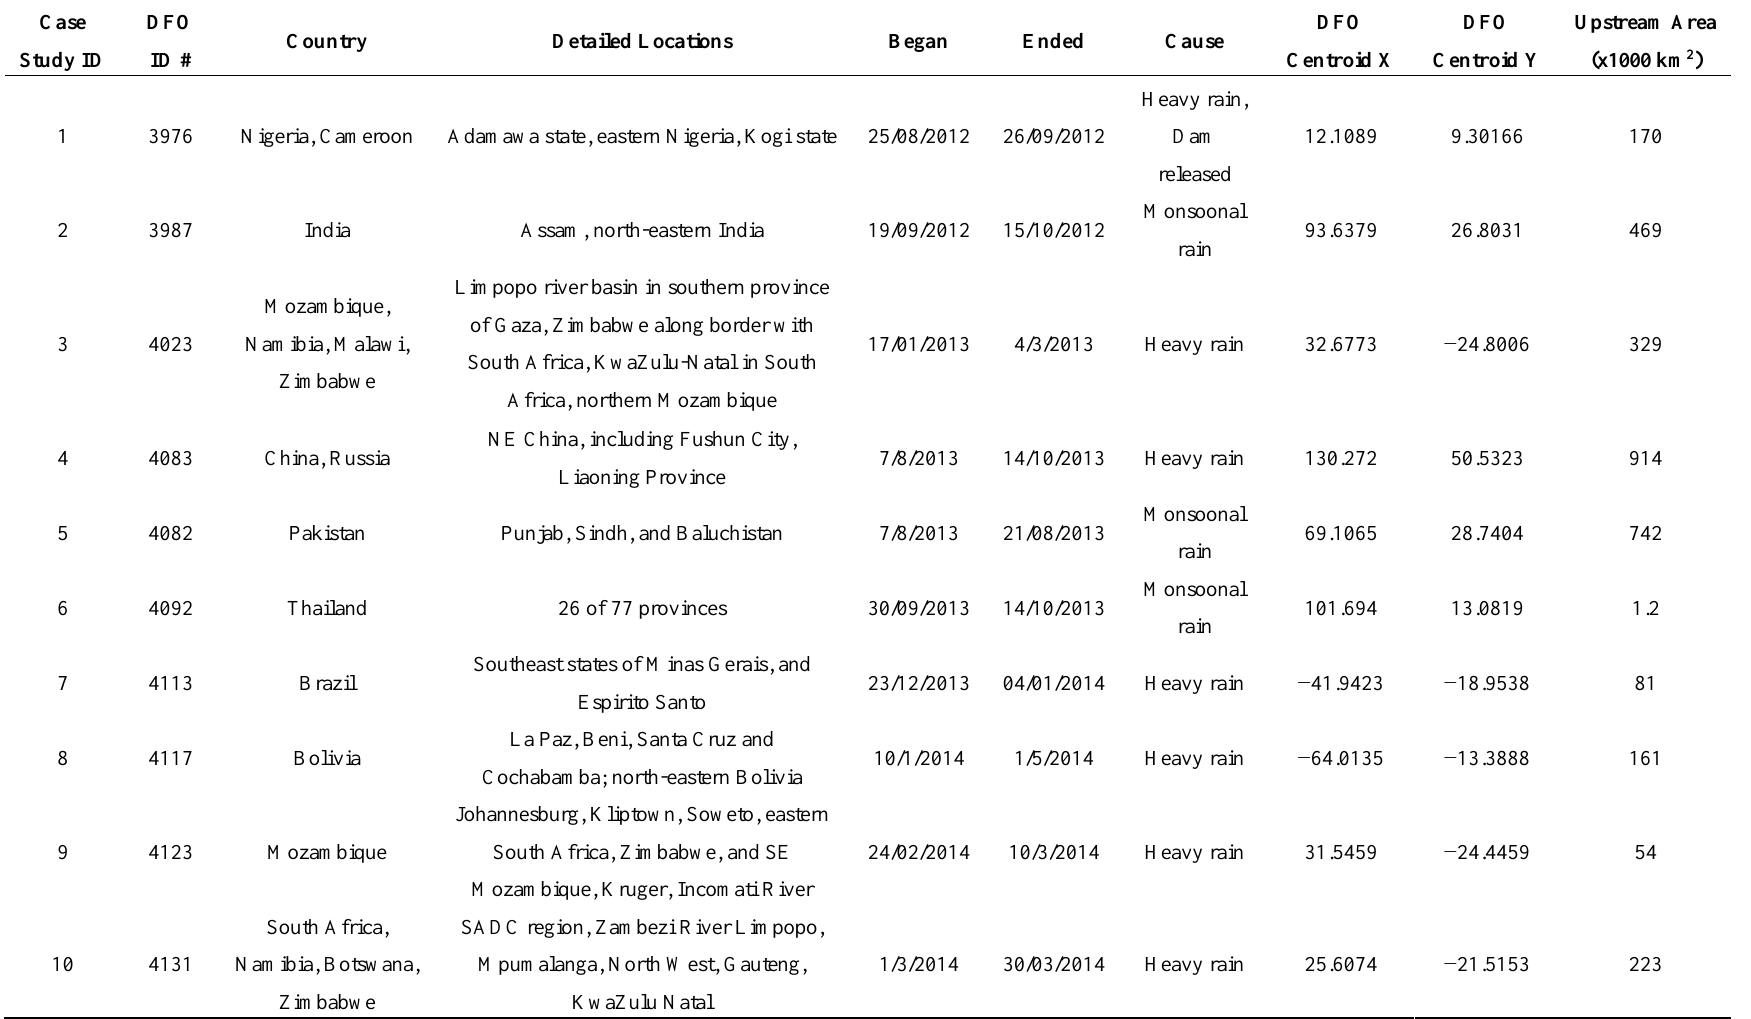
Table 1. List of the 10 selected flood case studies from the Dartmouth Flood Observatory Archive [47]. The upstream areas of the DFO centroids were calculated from the local drainage map of GloFAS